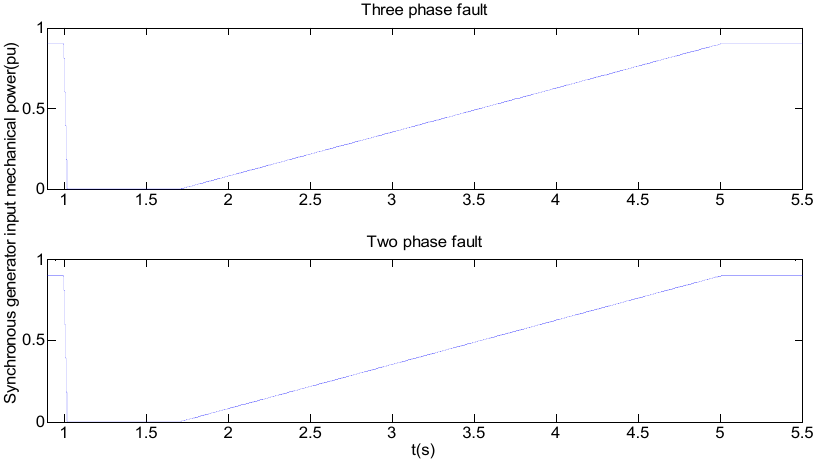
Figure 10. Synchronous generator input mechanical power.